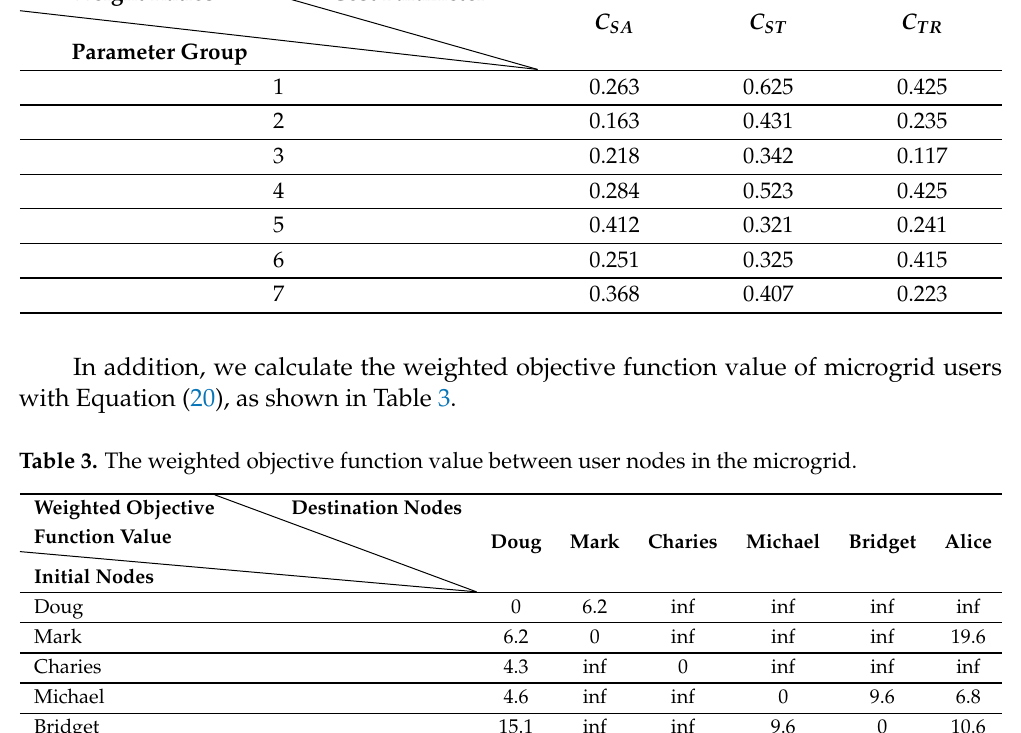
Parameter Group